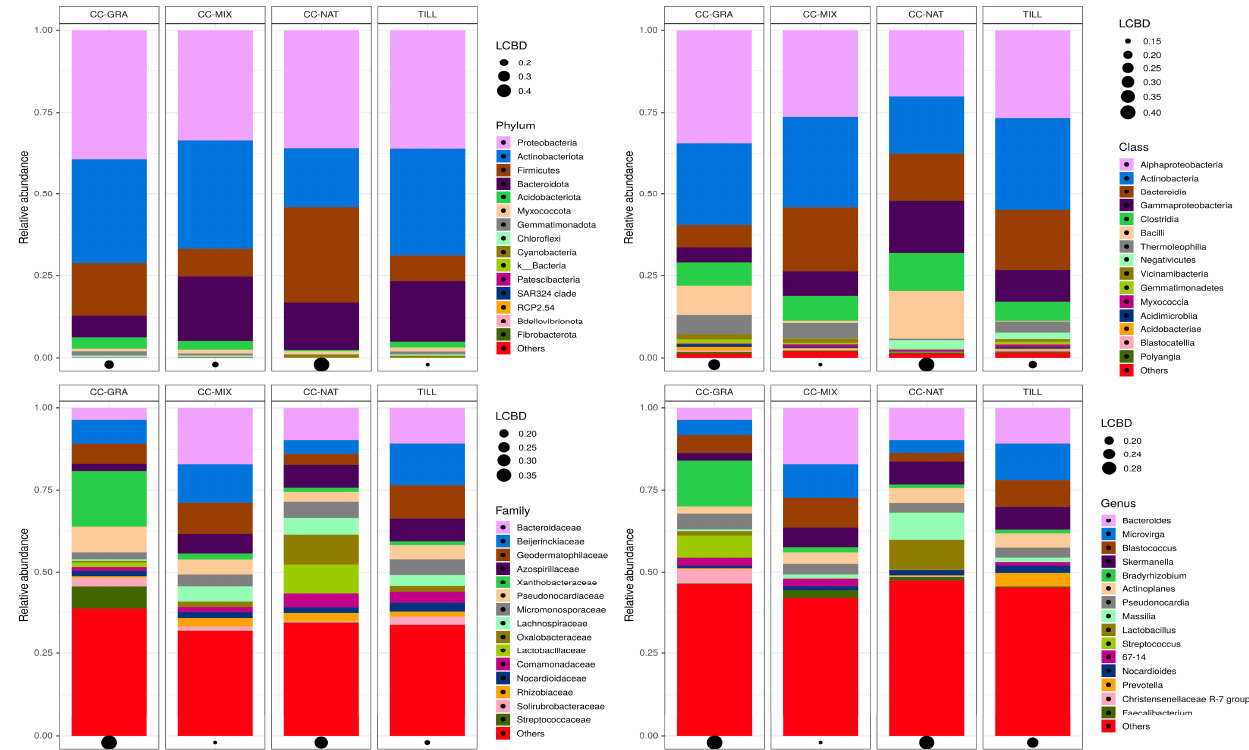
Figure 2. Bacterial relative abundances of the 15 most abundant taxa at four taxonomic levels (phylum, class, family and genus) grouped according to different soil cover crop managements (TILL: tillage, CC-GRA: sown cover crop with gramineous and CC-MIX: sown cover crop with a mixture of species) and CC-NAT (cover crop with spontaneous vegetation). The local contribution to beta diversity (LCBD) [50] is indicated as the points at the bottom of each bar with a diameter proportional to the magnitude of the LCBD